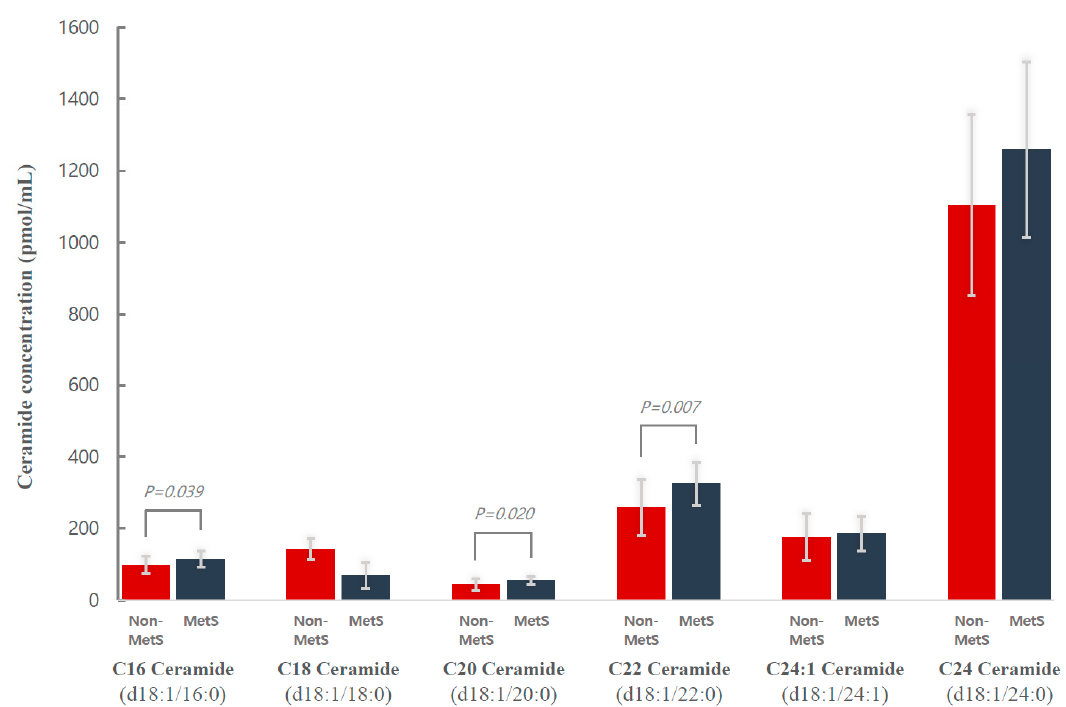
Figure 1. Mean baseline plasma ceramide concentrations in subjects who received Korean red ginseng (KRG) supplementation ( n = 36) with ( n = 18) and without metabolic syndrome ( n = 18). MetS, metabolic syndrome. Changes in plasma ceramide levels before and after the 4-week KRG intervention in the metabolic syndrome and non-metabolic syndrome groups are shown in Table 4. Among the subjects who received KRG, changes in the median levels of C16 ceramide